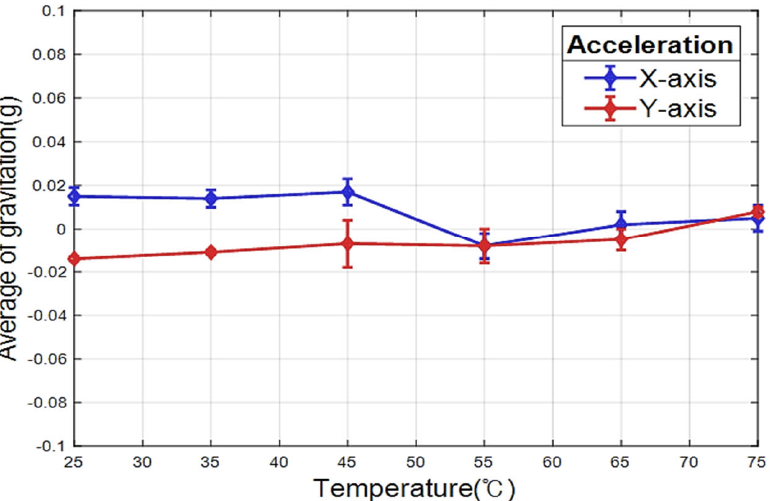
Figure 4. Averages and standard deviations of the measured values with temperature in the X and Y-axes of the accelerometer.